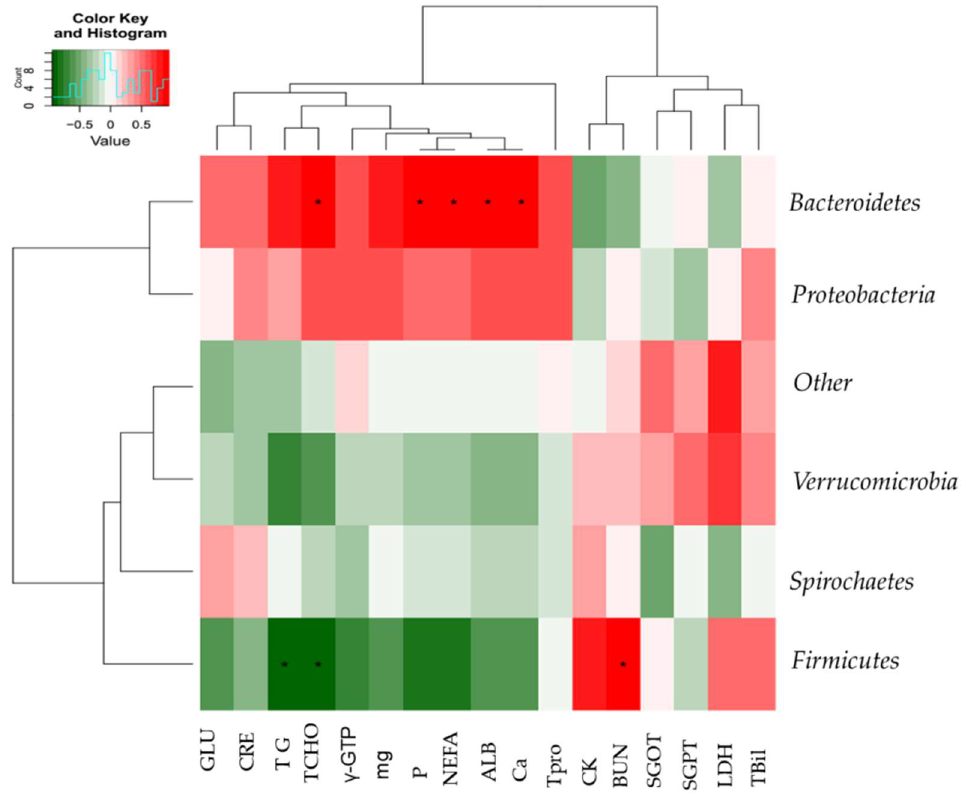
Figure 3. Heatmap correlation between the microbiota at the phylum level and serum metabolic profiles in experimental steers: Albumin (ALB), calcium (CA), creatinine kinase (CK), creatinine (CRE), gamma-glutamyl transferase ( γ -GTP), glucose (GLU), serum glutamate oxaloacetate transferase (SGOT), serum glutamate pyruvate transferase (SGPT), lactate dehydrogenase (LDH), blood urea nitrogen (BUN), total bilirubin (T-Bil), total protein (TPro); minerals such as calcium (ca), phosphate (p), magnesium (mg); and lipid profiles including total cholesterol (T-CHO), triglycerides (TG), and non-esterified fatty acids (NEFA). * Indicates statistical significant difference between grazing and housing steers at 0.05 level